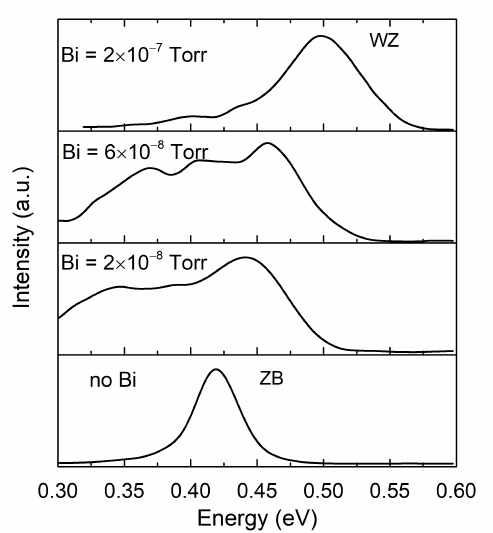
Figure 3. Photoluminescence emission spectra of InAs NWs taken at 8 K with different Bi-fluxes. Bi-flux varies from 2 × 10 − 8 Torr to 2 × 10 − 7 Torr. Bottom panel of the figure is the reference sample with zero Bi-flux, indicating ZB nanowire energy bandgap, and the top panel shows highest Bi-flux and WZ energy